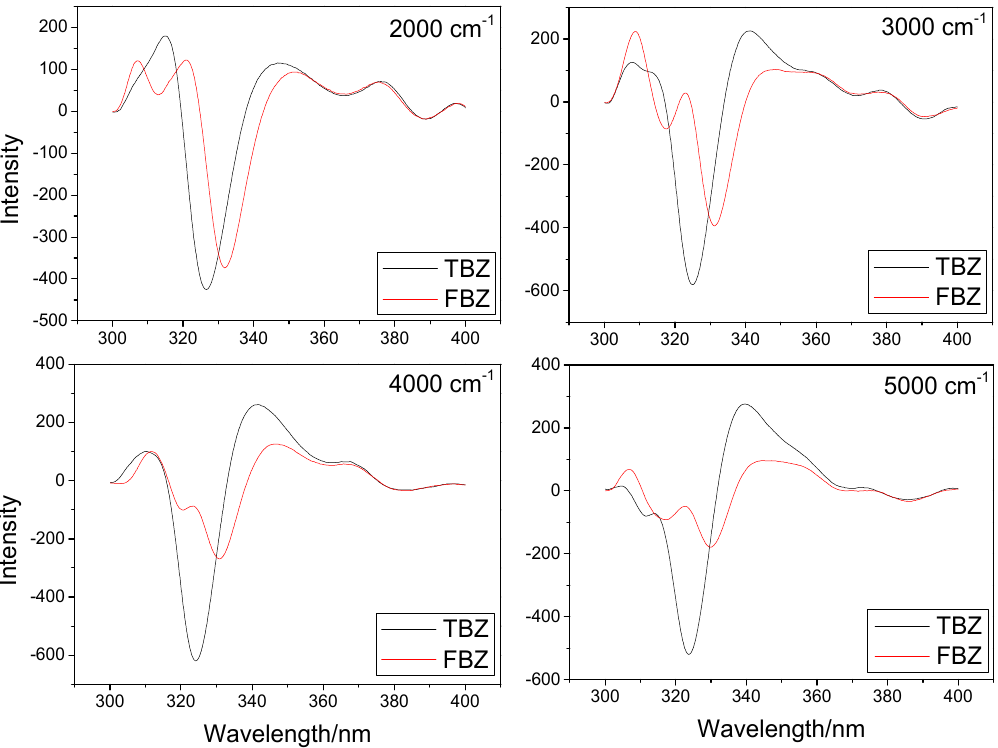
Figure 2. Second derivative constant-energy synchronous fluorescence spectra of TBZ (300 ng/mL) and FBZ (30 ng/mL) at different constant-energy differences (cm − 1 ).